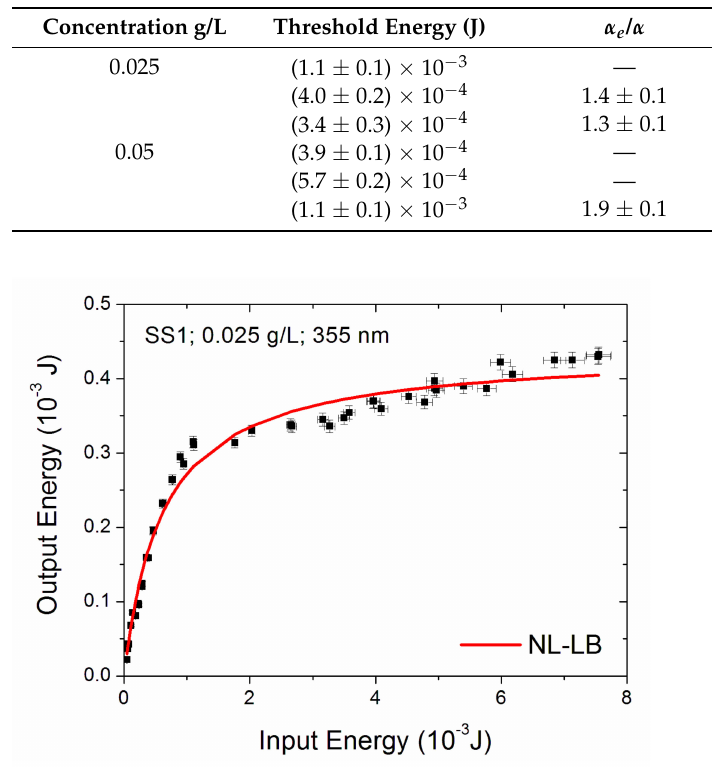
Figure 6. Strong OL obtained in the 0.025 g/L concentration sample and with 355 nm laser wave- length. The NL-LB equation (continuous curve) is not able to reproduce the experimental data. Neither the MMJ model can be applied due to lack of convergence with this